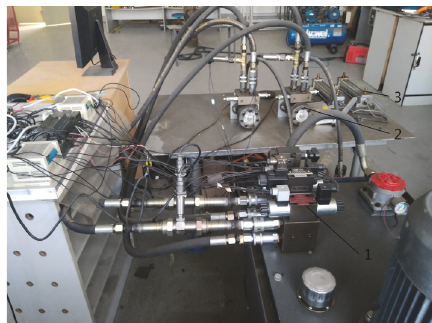
Figure 12: Hydraulic driven test bench of intelligentflexible sprayer chassis. (1) Electromagnetic proportional directional control valve; (2) hydraulic motor; (3) hydraulic